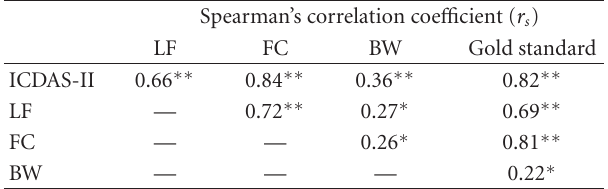
Table 2: Spearman’s correlation coe ffi cients between di ff erent